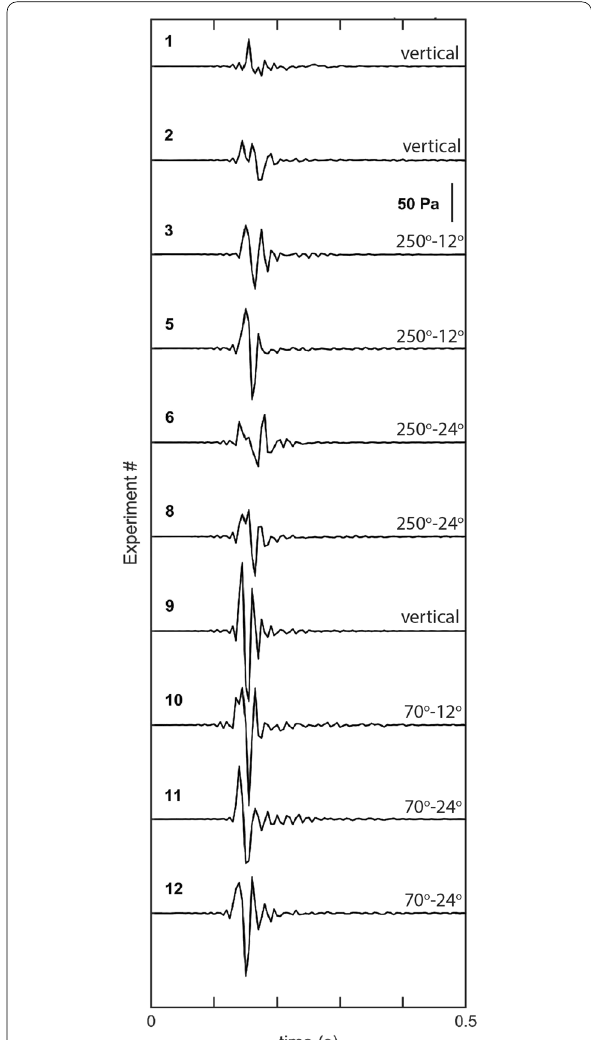
Fig. 2 Example discharges from sensor AC32 located under the source (SRC). Each discharge is labeled as described in Table 2. Note the highly variable waveform characteristics event-to-event. The window onset is ~ 0.1 s prior to the explosion onset for each